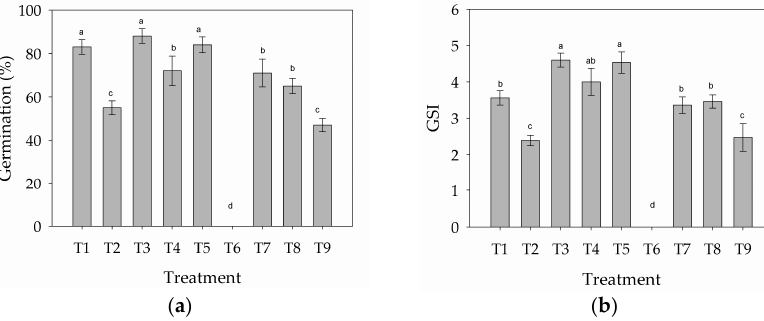
Figure 1. Germination percentage ( a ) and germination speed index ( b ) of Melanoxylon brauna seeds under different temperatures (T1: 25 °C; T2: 35 °C; T3: 35 °C/24 h; T4: 35 °C/48 h; T5: 35 °C/72 h; T6: 45 °C; T7: 45 °C/24 h; T8: 45 °C/48 h; T9: 45 °C/72 h). Vertical bars = ±SE, n = 5.